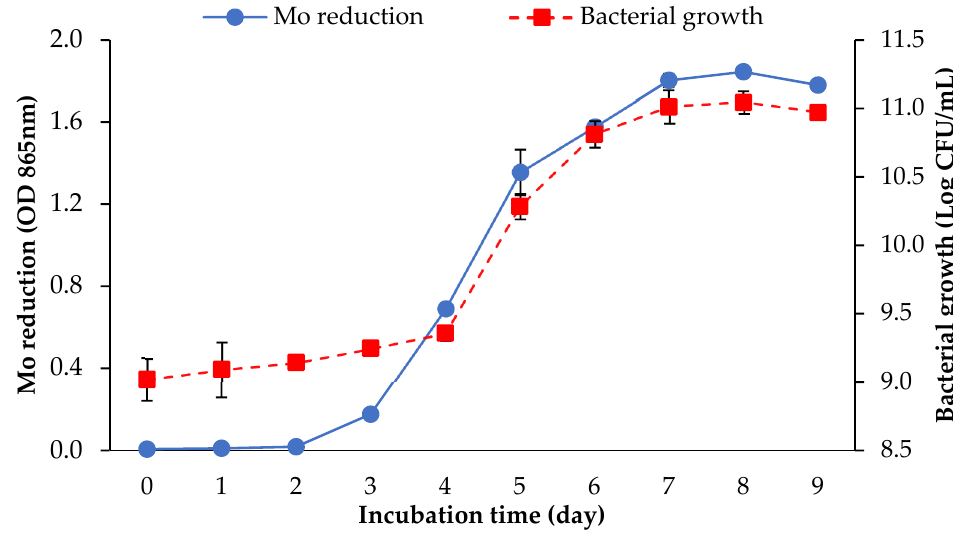
Figure 1. Molybdate reduction and growth of Arthrobacter sp. strain AQ5-A5 isolate in LPM.